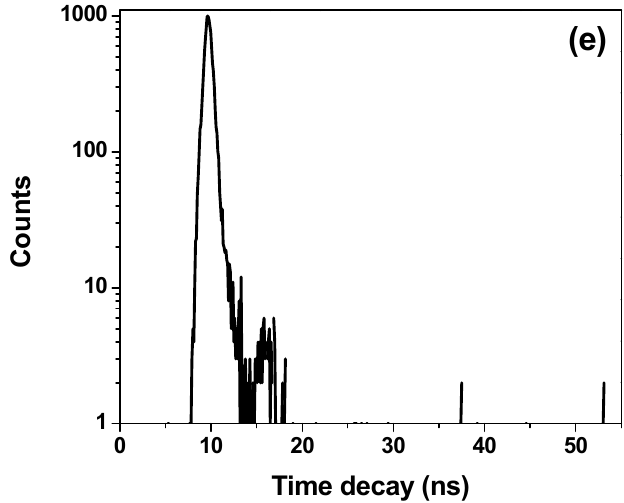
Figure 9. Lifetime decays of PFO/10 wt% MEH-PPV with various ratios of STNCs ( a ) 0, ( b ) 5 wt%, ( c ) 10 wt%, ( d ) 15 wt% & ( e ) 20 wt% at emission wavelength of 580 nm. λ ex = 376.4 nm. Table 3. Main fitting parameters and lifetime decays of PFO/10 wt% MEH-PPV hybrid thin film with various content of STNCs. At λ em. 440 nm At λ em. 580 nm